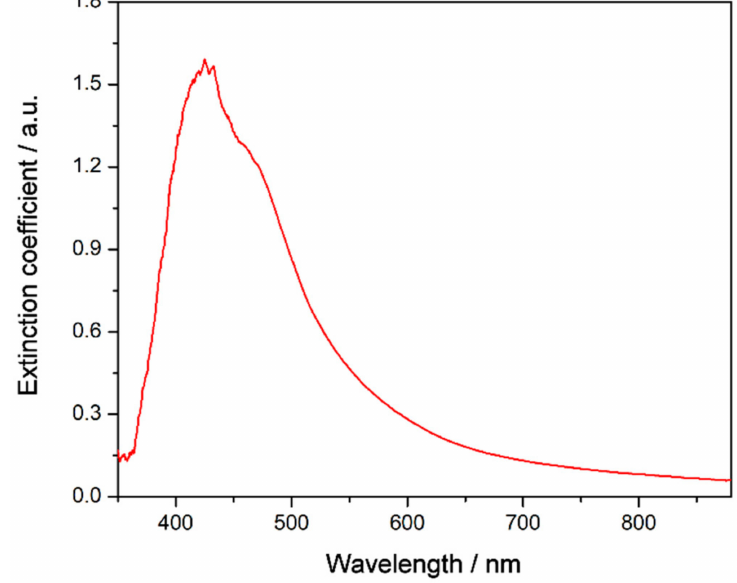
Figure 7. UV-vis spectrum of the TiO 2 -based nanofluid just after